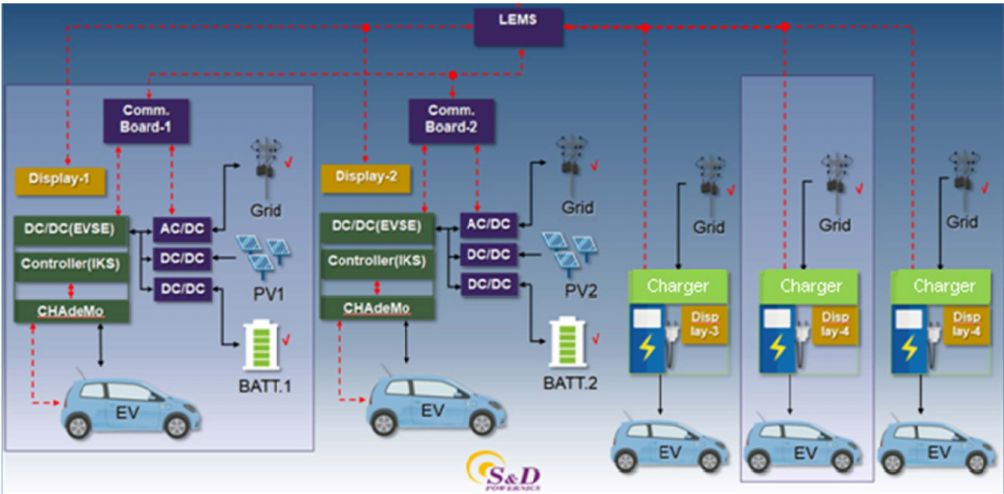
Figure 5. Block diagram of V2X testbed.